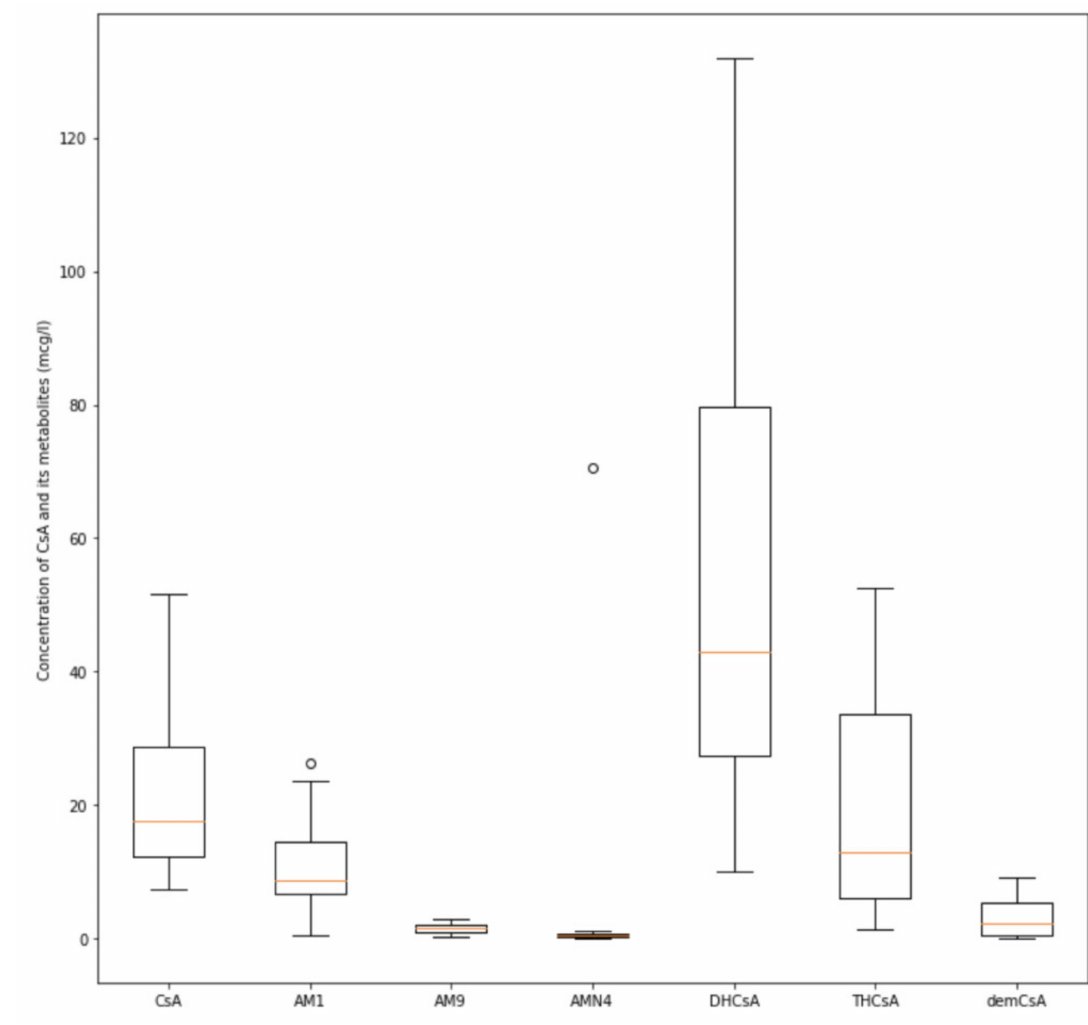
Figure 2. The distribution of cyclosporine A (CsA) and its monohydroxylated (AM1, AM9) dihydroxylated (DHCsA), trihydroxylated (THCsA), demethylated (AMN4), and demethylated- carboxylated (demCsA) metabolite concentrations in colostrum (mcg / L), ◦ = outlier